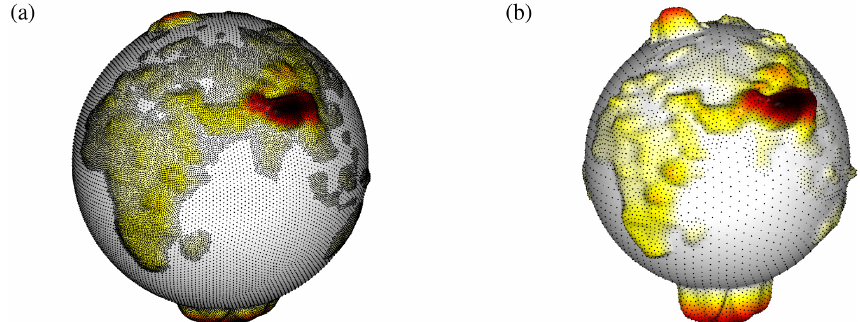
Figure 2. Example of the discretization of the Earth’s topography under the change of variable (Eq. 16): (a) β = 0 . 05 and ∼ 150km resolution at sea level. (b) β = 1 and ∼ 400km resolution at sea level.